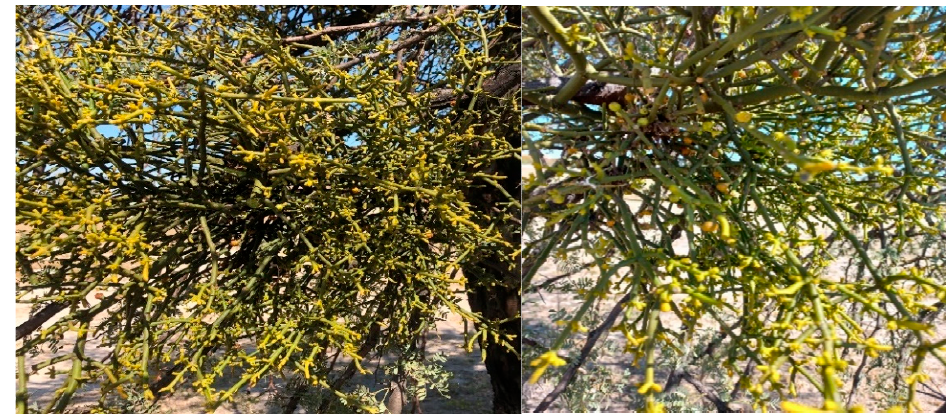
Figure 2. Viscum verrucosum Harv. in North West Province, photos taken by O Hawu.